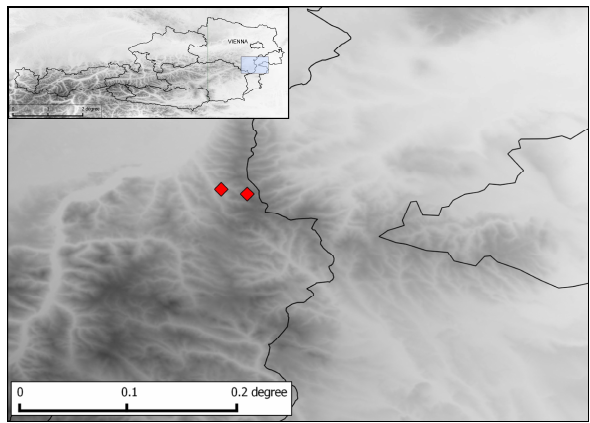
Figure 2a. Pollen concentrations (Pollen m − 3 ) of European beech on 23 April 2009, at the three levels of the tower.